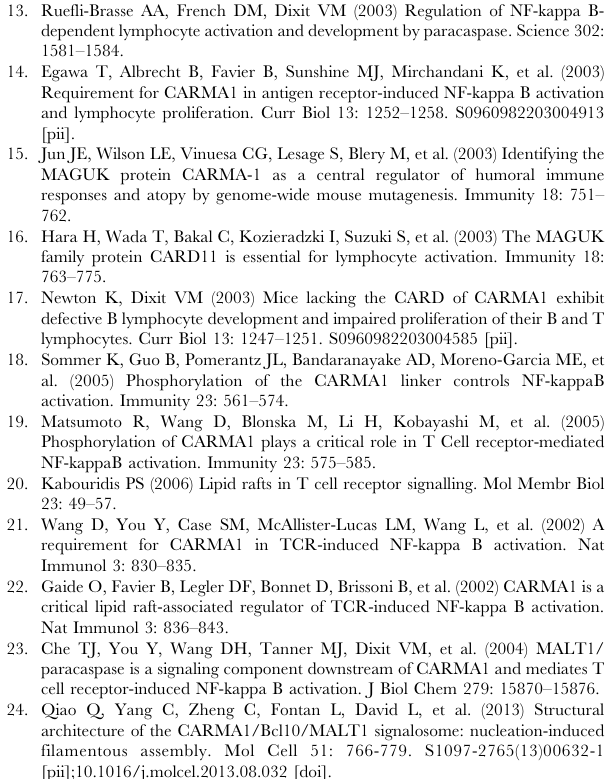
Table S1 Sequences of primer pairs used for qRT-PCR analysis.